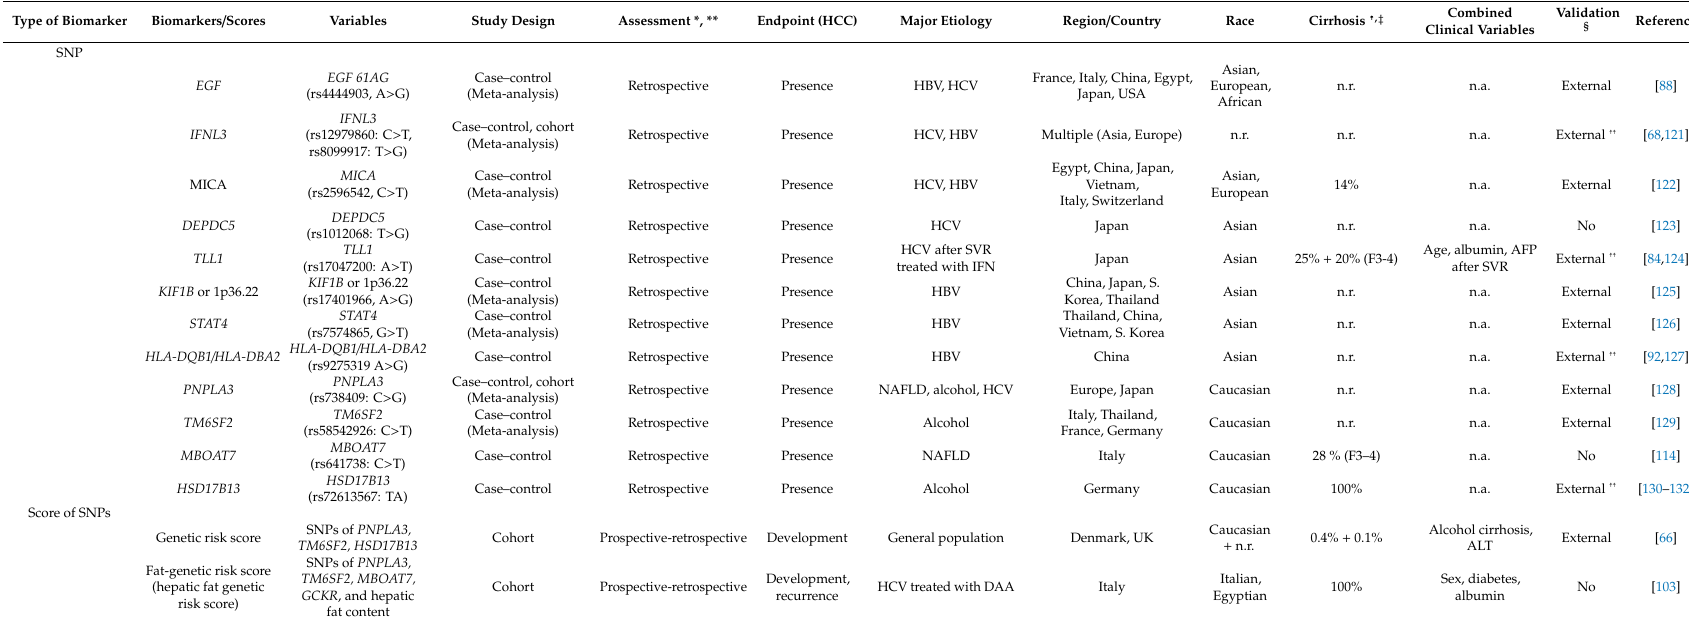
Table 2. Molecular HCC risk biomarkers. Type of